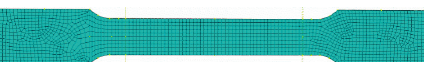
Figure 5: The smooth round bar specimens.